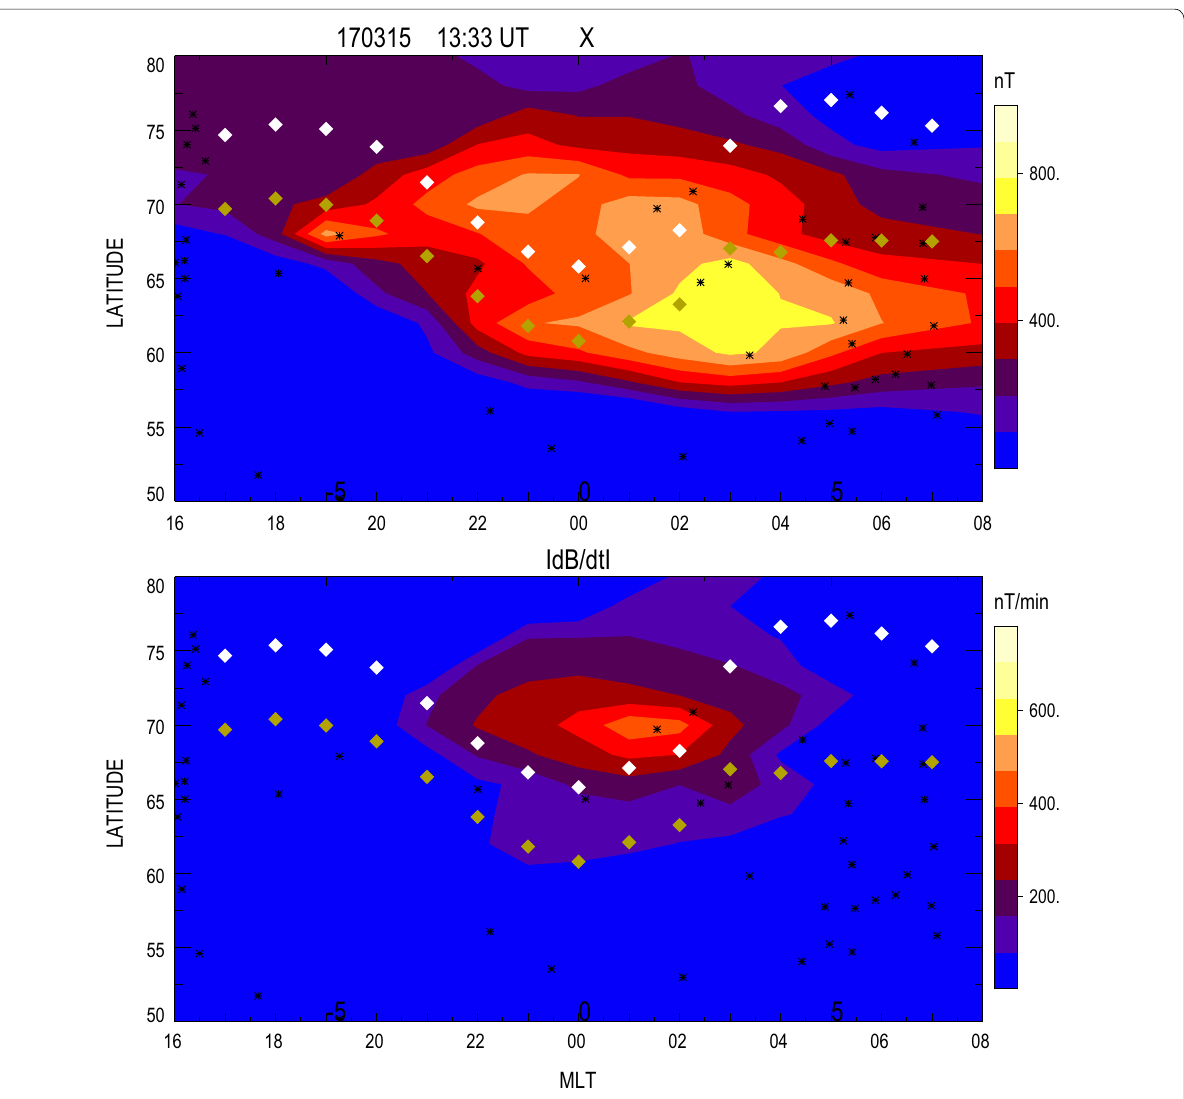
Fig. 3 World-wide distribution of magnetic disturbance magnitude for the time moment 1333 UT (substorm #2) on March 17, 2015, as characterized by the global Φ -LT maps of Δ X variations (upper panel), and magnetic variability |d B /d t | (bottom panel). Small black crosses denote the station location. Black and yellow diamonds denote the poleward and equatorward boundaries of the auroral oval, given by the OVATION